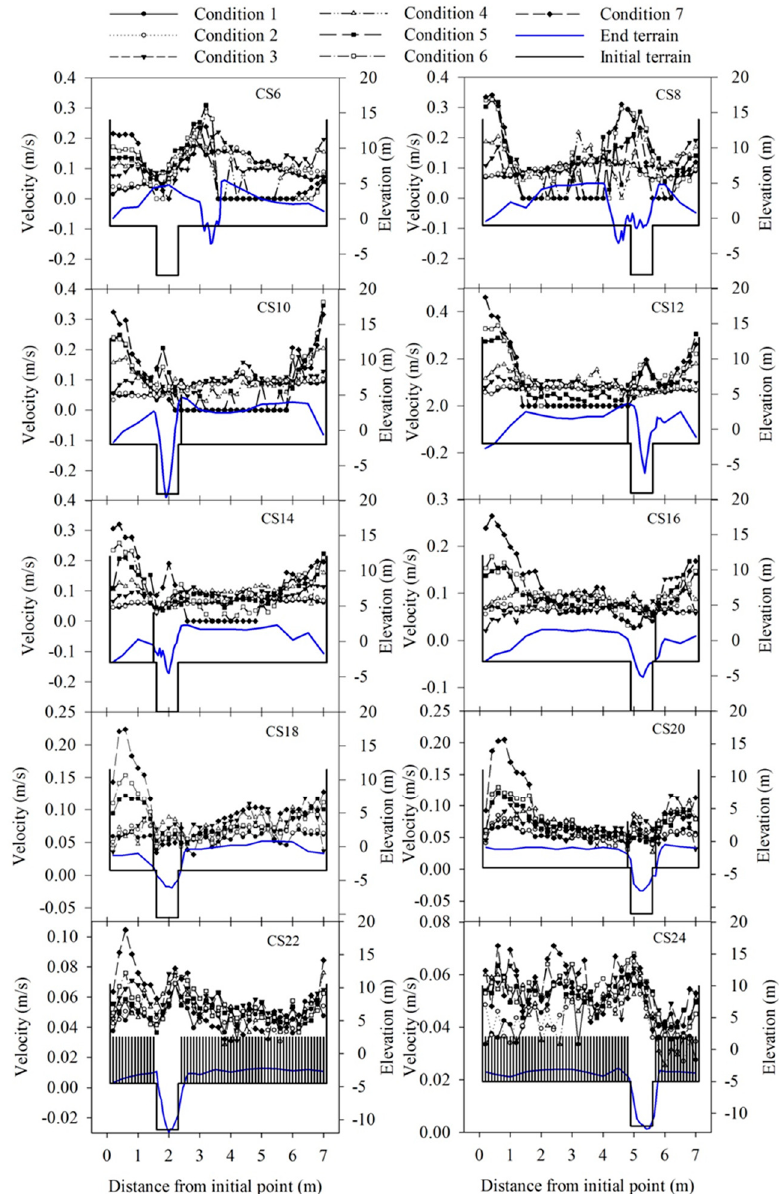
Figure 4. Comparison of the velocity and topography of meandering compound channel sections under different working conditions (The blue line is the terrain at the end of all working condi- tions).